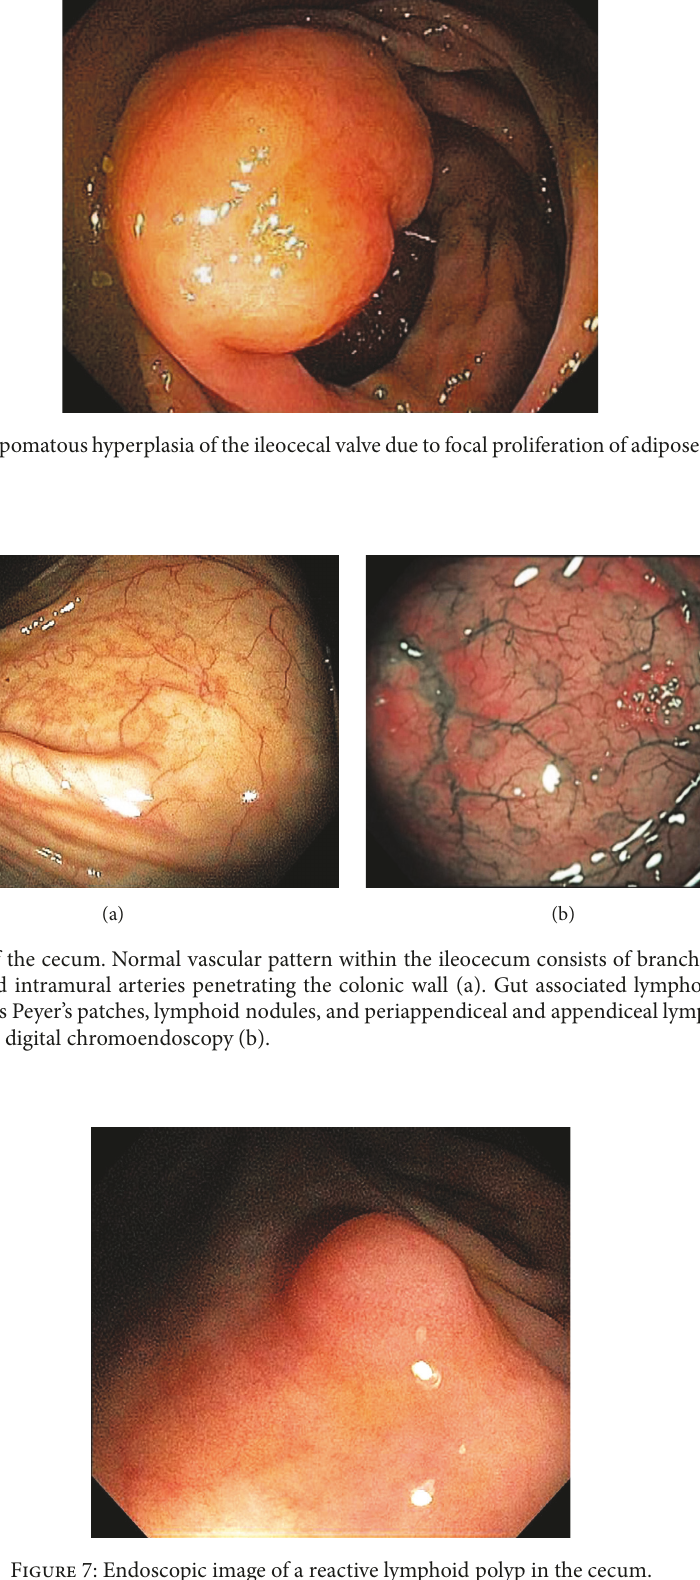
Figure 7: Endoscopic image of a reactive lymphoid polyp in the